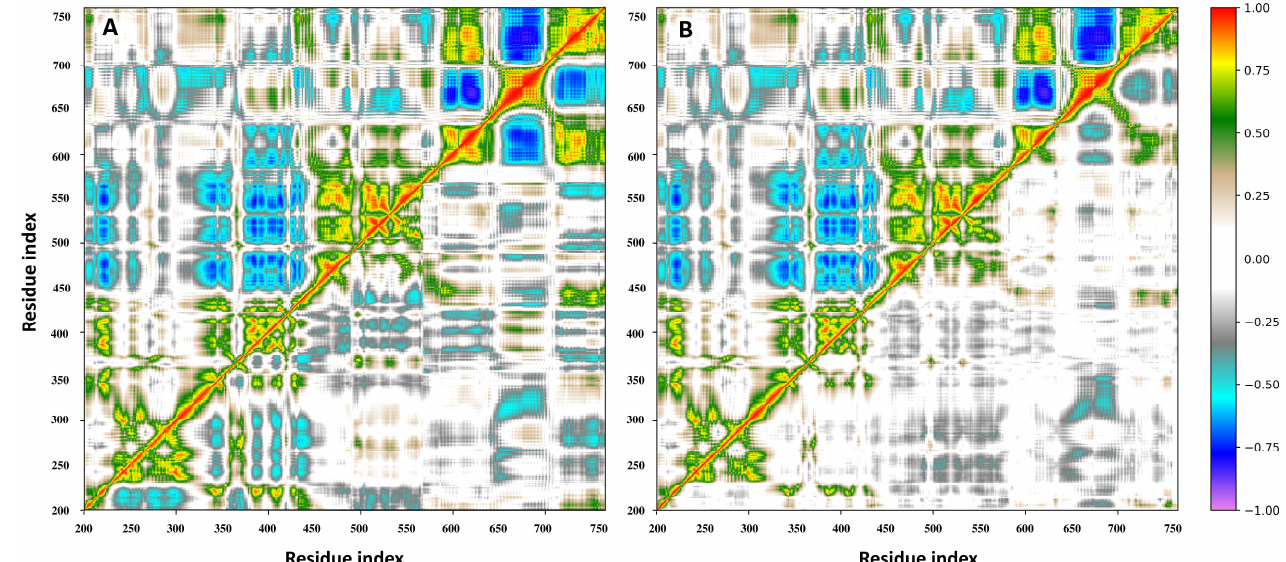
Figure 8. DCCMs obtained for the three simulated systems. The upper-left triangles of the graph represent the DCCM for the unbound hTop1-DNA complex, while the lower-right triangles show the DCCMs for the drug in the catalytic site ( A ) or intercalated within the DNA bases ( B ), respectively. Color coding is reported in the legend. Positive values between two residues indicate a correlated motion, while the negative values indicate an anti-correlated motion.